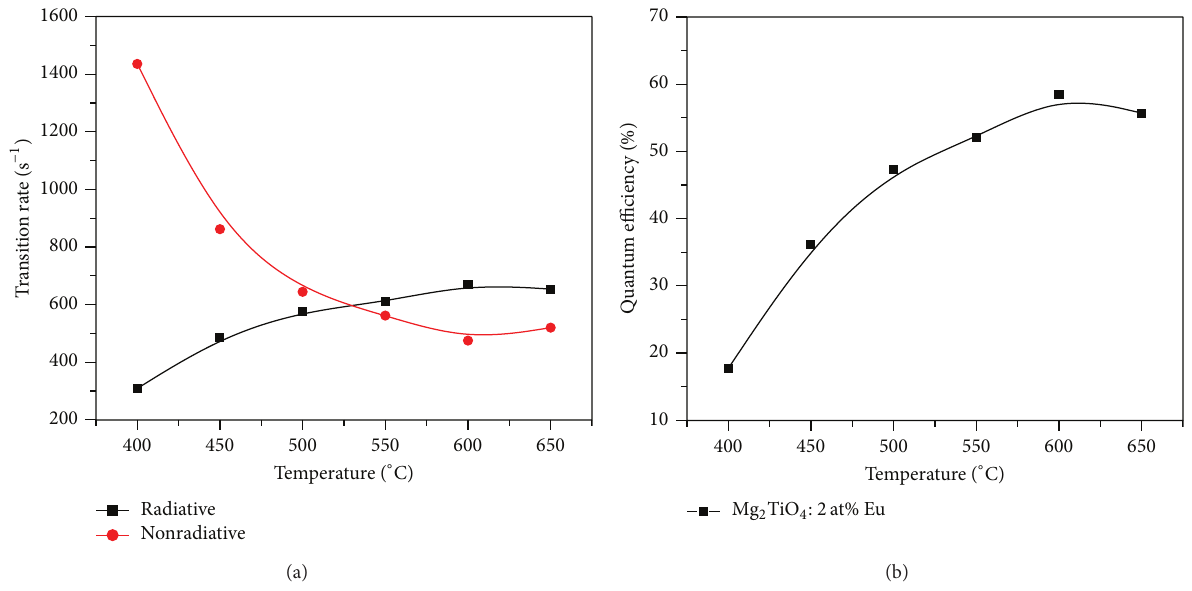
Figure 5: (a) Radiative (black squares) and nonradiative transition rates (red circles) and (b) quantum efficiency of Eu 3+ emission in Mg 2 TiO 4 nanoparticles prepared at different